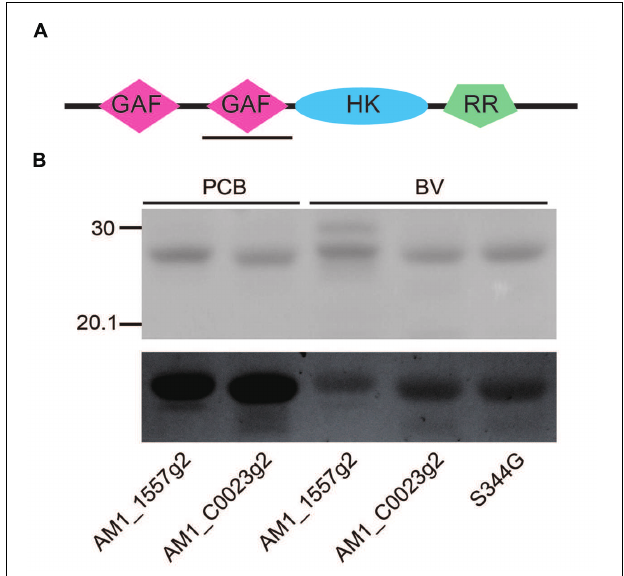
FIGURE 1 | (A) Domain structure of the full-length gene product, AM1_C0023. GAF: cGMP-phosphodiesterase/adenylate cyclase/FhlA domain, HK, Histidine kinase domain; RR, response regulator domain. Expressed second GAF domain, AM1_C0023g2, was highlighted by black solid underline. (B) SDS-PAGE analyses of PCB- and BV-binding AM1_1557g2 and AM1_C0023g2. Upper gel image: Coomassie Brilliant Blue stained gel. Lower gel image: Linear tetrapyrroles covalently bound to CBCR GAF domains were detected by in-gel fluorescence imaging. The Zn 2 + -staining was performed as previously described (Berkelman and Lagarias, 1986). The gel was directly subjected to fluorescence detection. The gel image was provided with black-and-white inversion for easy detection of fluorescent